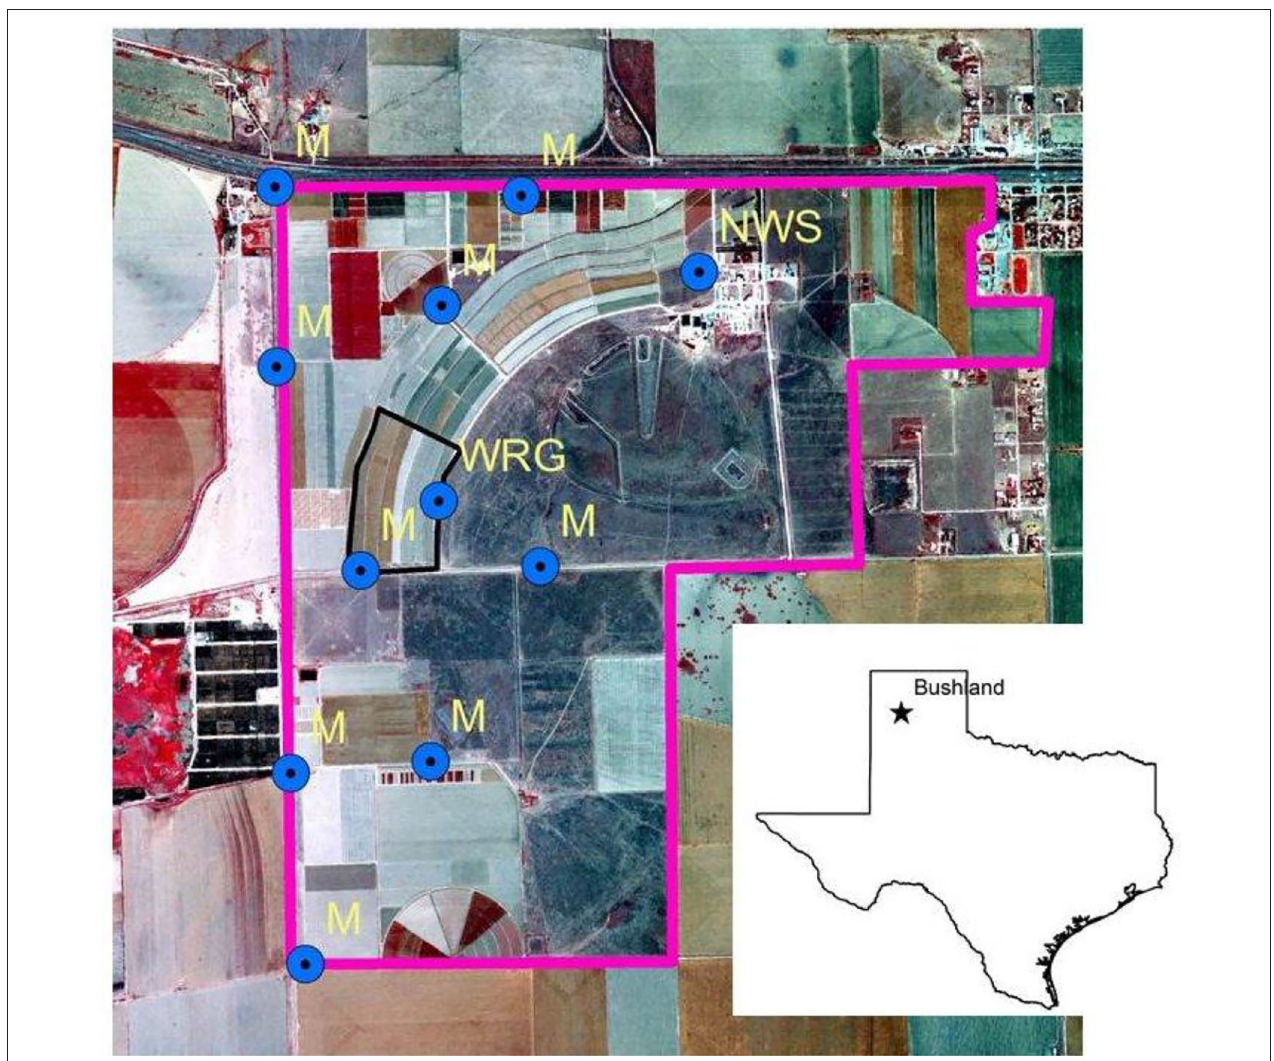
FIGURE 1 | Locations of rain gauges, and runoff plots at the Conservation and Production Research Laboratory in Bushland, Texas, USA. The insert in the lower right corner shows the location of Bushland within the state of Texas in the United States. The area outlined with a pink line is the Conservation and Production Research Laboratory. The six runoff plots are outlined in a thinner black line. Rain gauges are depicted as blue circles with a black dot in the center. Those rain gauges designated with M as manual ones that are measured after each rain event. The rain gauge designed WRG is the continuous weighing rain gauge, the primary source for rain fall data. The rain gauge designated NWS is associated with National Weather Service weather